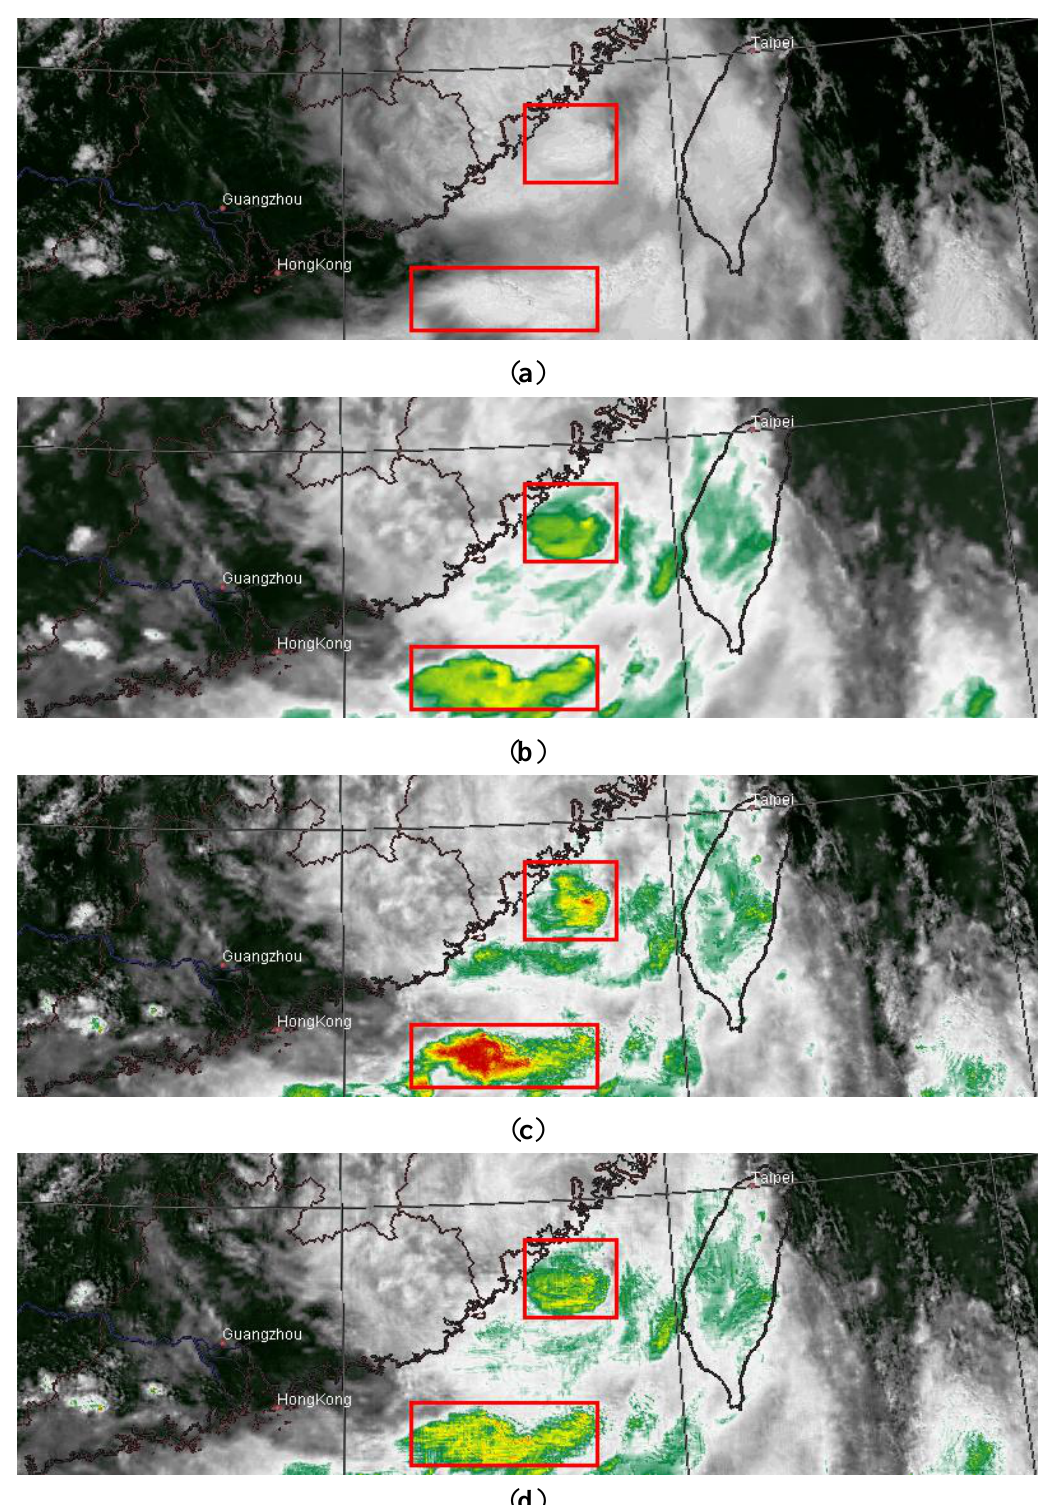
Figure 5. MTSAT images of South China and Taiwan on 1300 LST 25 July 2006. ( a ) VIS image; ( b ) IR image; ( c ) Fused image. Red boxes indicate areas with serious spectral distortion; ( d ) Corrected